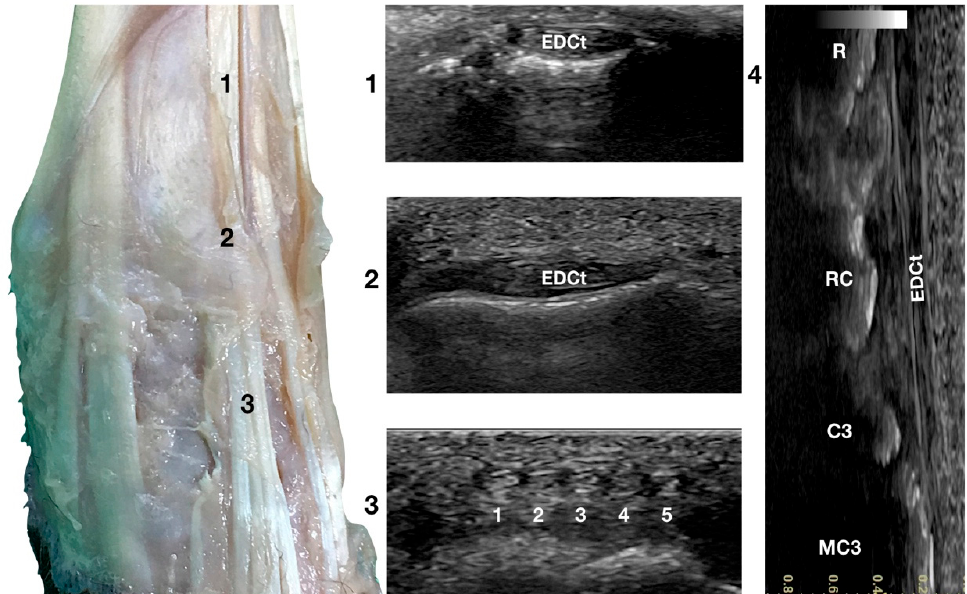
Figure 3. Dorsal carpal face centred on the Extensor Digitorum Communis tendon. At the ulnar notch level (2), the EDC tendon is thin and large, easily differentiated from the ECRt by its shape and position. Dorsally, just distal to the tenomuscular junction (1), the tendon is thicker and narrower. At the level of the radiocarpal joint (3), the tendon subdivides into four small tendons (white 2 to 5). The small, medial tendon of the Extensor Digiti I Longus is often visible (white 1). On the longitudinal scan plane (4), the fine fibrillar pattern of the thin tendon is visible. The image shows the part of the tendon that crosses the radius (R), the radiocarpal bone (RC), the carpal bone three (C3), and the third metacarpal bone